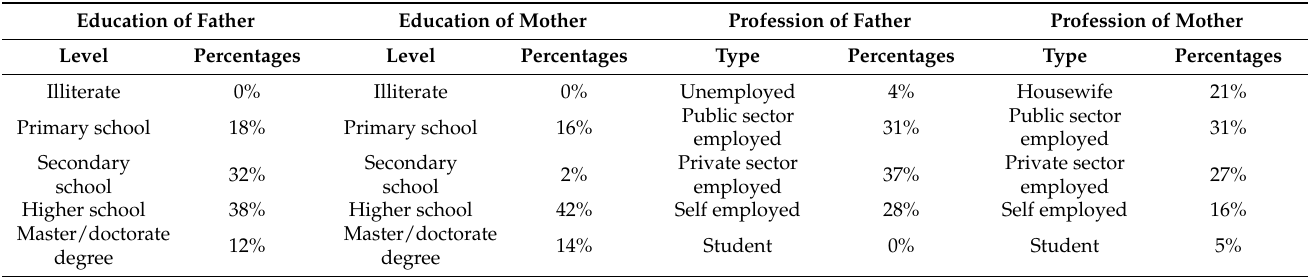
Table 1. Characteristics of